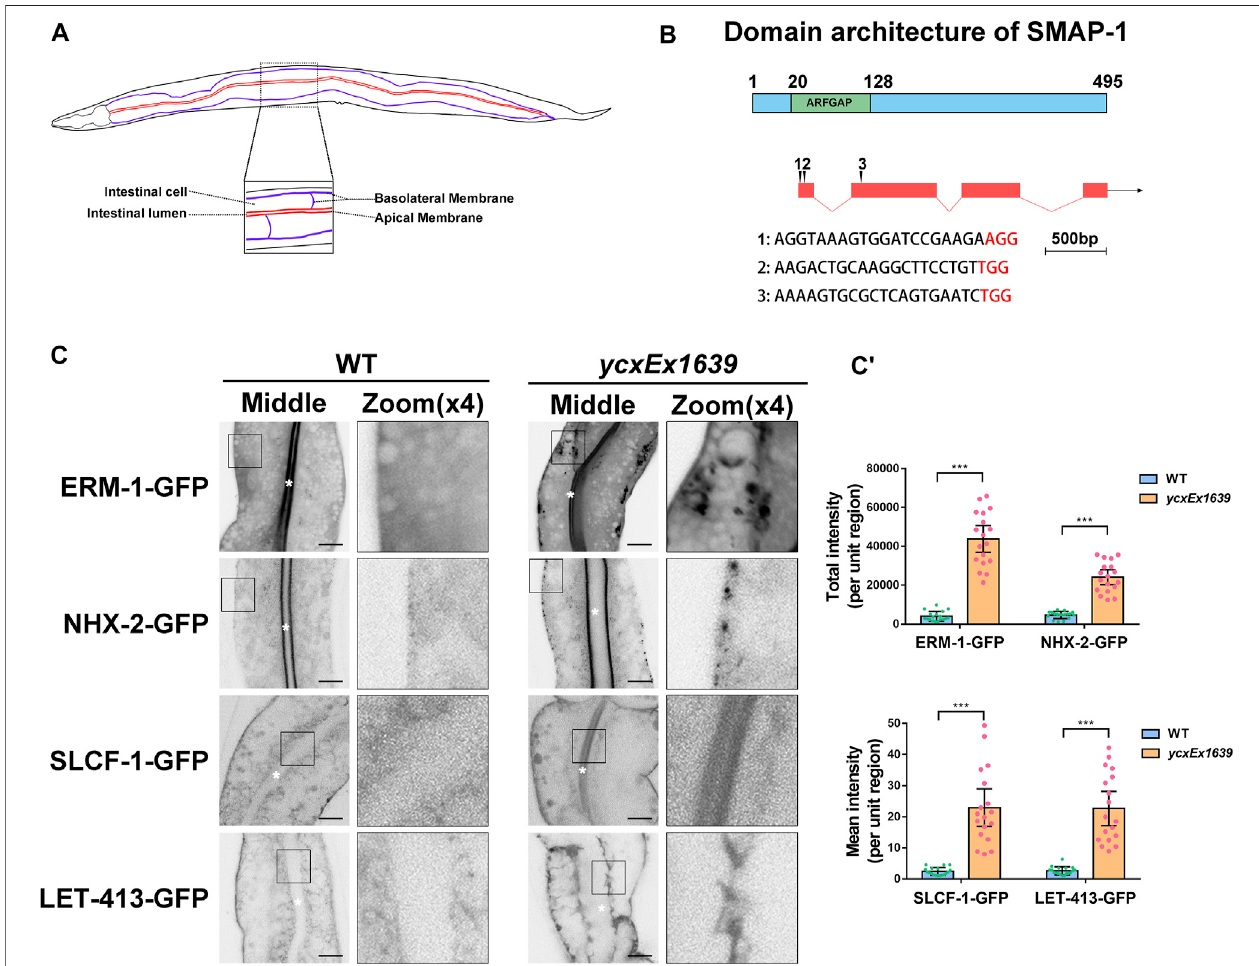
FIGURE 1 | Loss of SMAP-1 disturbs the polarized secretion in the intestine. (A) A model of the C. elegans intestine indicates the apical and basal sides of intestinal epithelia. (B) SMAP-1 contains an N-terminal ArfGAP domain, and amino acid numbers are indicated. (C-C 9 ) In smap-1(ycxEx1639) mutants, ERM-1- GFP and NHX-2-GFP accumulated on the basolateral side, while SLCF-1-GFP and LET-413-GFP appeared on the apical membrane. White asterisks indicate intestinal lumen. Error bars are 95% CIs (n (cid:1) 18 each). Asterisks designate the signi fi cant differences in the Mann-Whitney test (*** p < 0.001). Scale bars, 10 μ